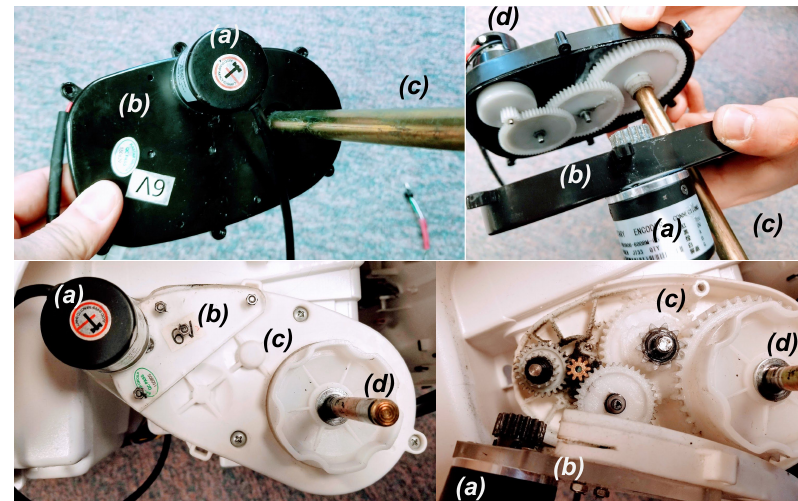
Figure 6. Gearboxes. ( Top-Left ): The steering wheel gearbox with an encoder attached. ( Top-Right ): An exploded view of the modified steering gearbox. ( a ) The encoder. ( b ) The gearbox. ( c ) The steering wheel shaft. ( d ) The steering motor. ( Bottom-Left ): The motor gearbox with an encoder attached. ( Bottom-Right ): An exploded view of the modified driving gearbox. ( a ) The encoder. ( b ) The custom design support fixture. ( c ) The driving gearbox. ( d ) The driving motor shaft.